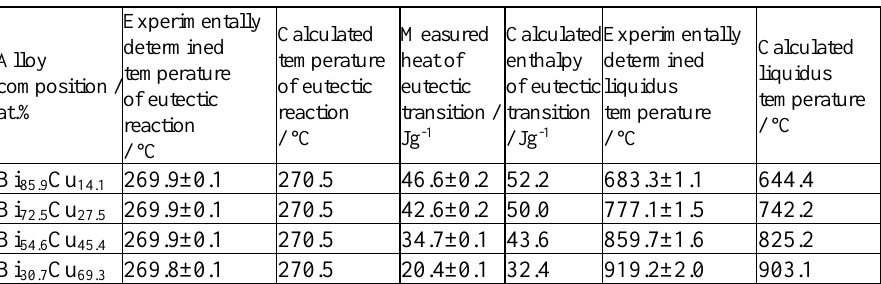
Table 2. Comparison between the results of DSC measurements and thermodynamic calculations for the Bi–Cu eutectic